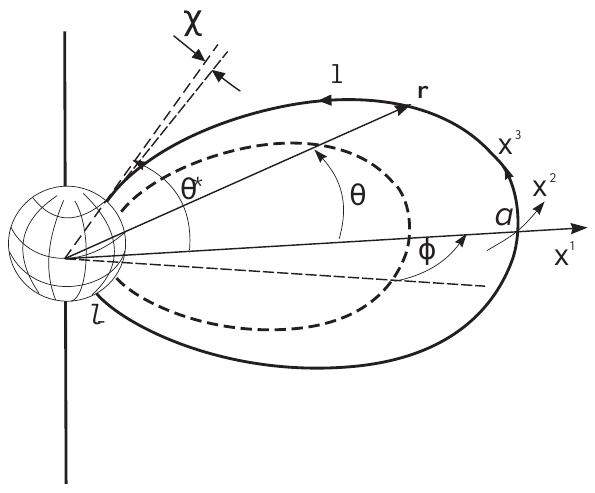
Fig. 1. The curvilinear orthogonal coordinate system ( x 1 ,x 2 ,x 3 ) of the magnetic field lines and the non-orthogonal coordinate system ( a,φ,θ ) used in numerical